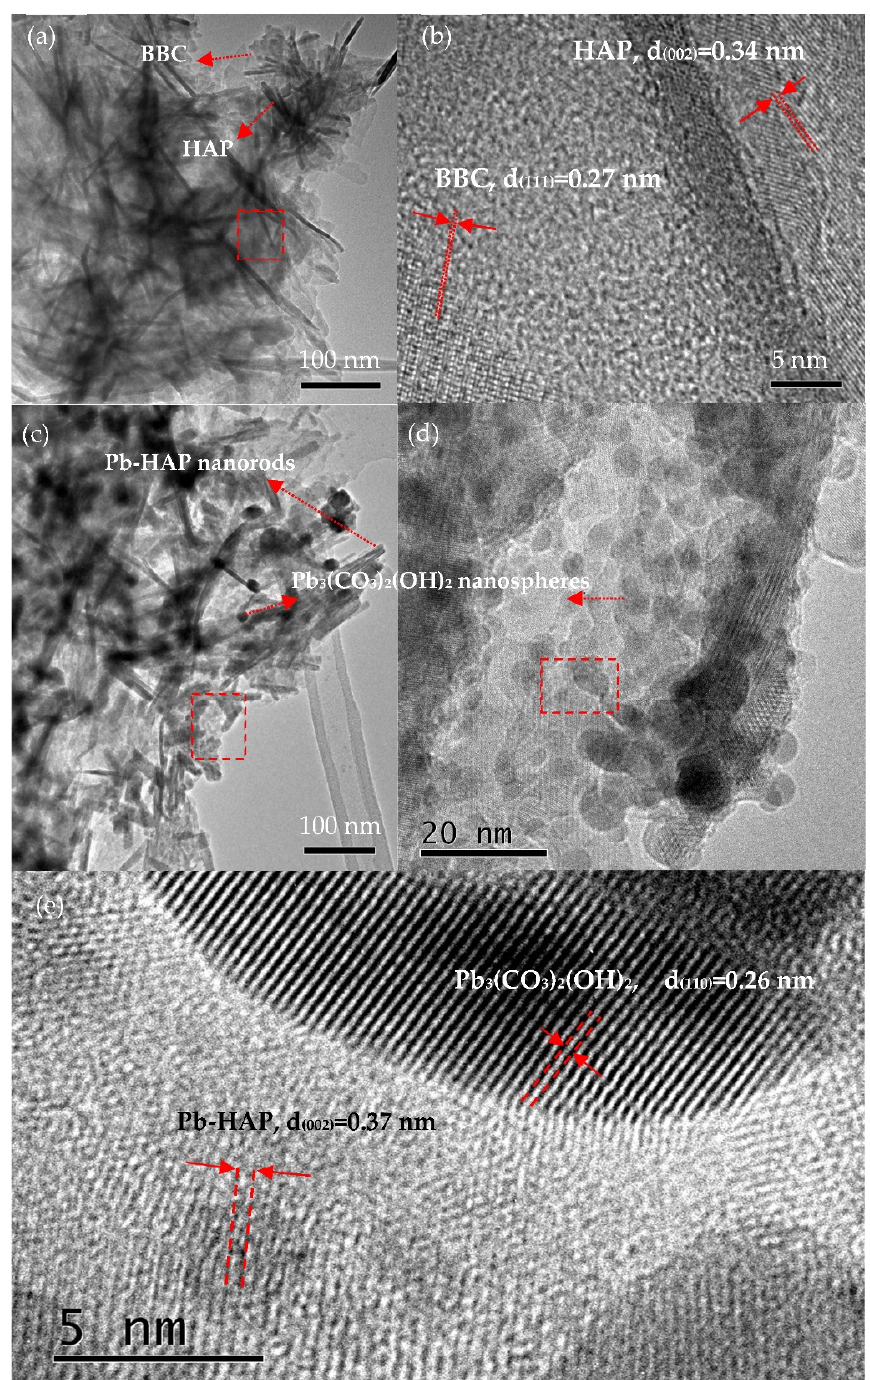
Figure 9. TEM and HRTEM images of S3 before ( a , b ) and after ( c – e ) adsorption of Pb 2+